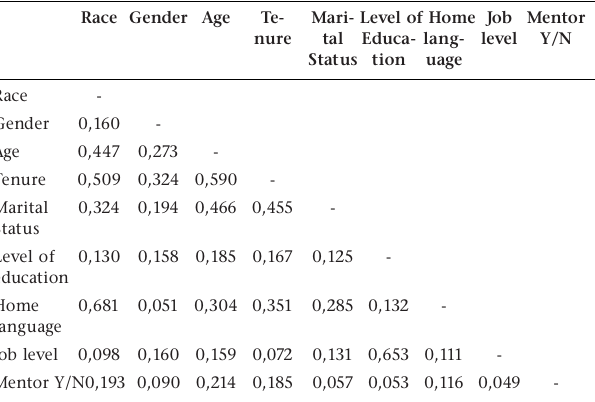
Key for interpreting effect sizes: < 0,1 – no effect 0,1 to 0,3 – small effect 0,3 to 0,5 – moderate